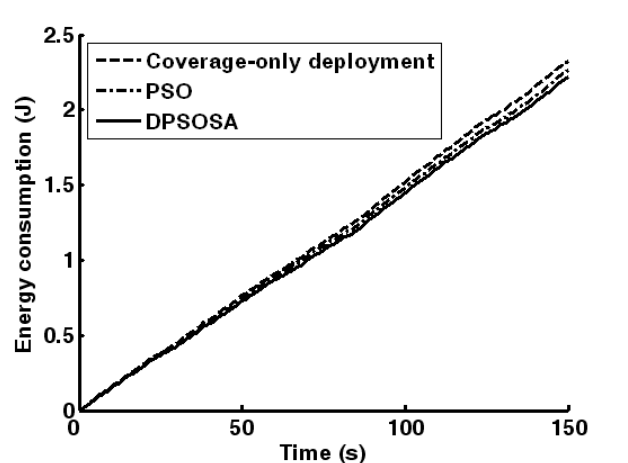
Figure 8. Energy consumption comparison of WSNs optimized by PSO and DPSOSA in target tracking